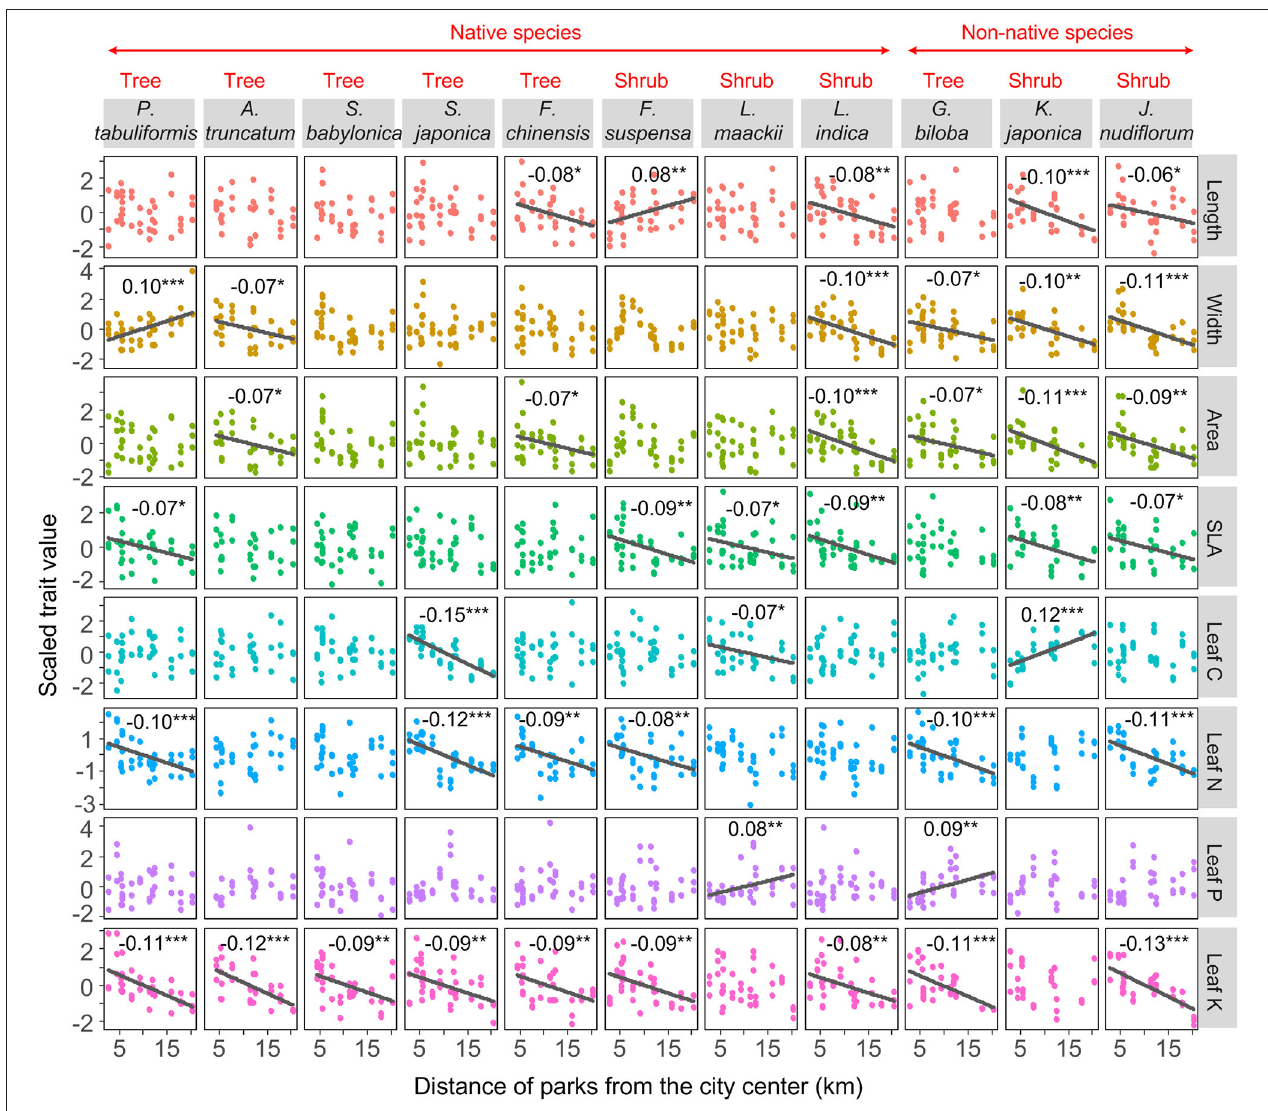
FIGURE 2 | Changes in leaf functional traits along the urban–rural gradient for each species, fitted with general linear models, with trait as the response variable and distance as the predictor variable. Trait values were scaled to zero mean and unit standard deviation in order to plot them on the same scale. The sign is the slope of changes in leaf functional traits along an urban–rural gradient. Regression lines and slopes are shown when changes are significant (*** p < 0.001, ** p < 0.01, * p <